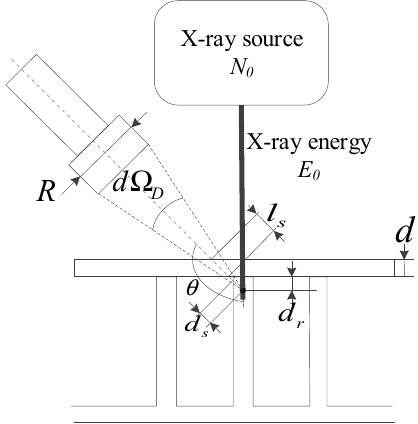
Figure 11. Modeling of X-ray backscattering detection.